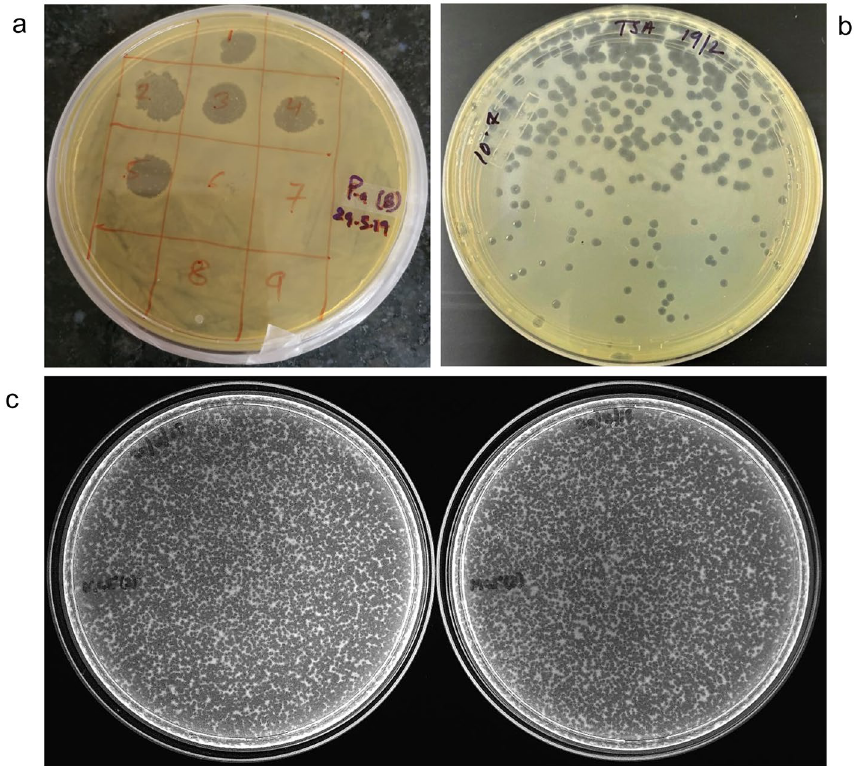
Figure 1. Plaques of Pseudomonasphage DRL-P1 on P. aeruginosa lawn . ( a ) A clear zone of lysis was observed in spot-test. ( b ) Clear plaques were observed after double layer agar plating of enriched phages ( c ) ‘ Web-pattern ’ plates for preparation of high titer phage lysate for different